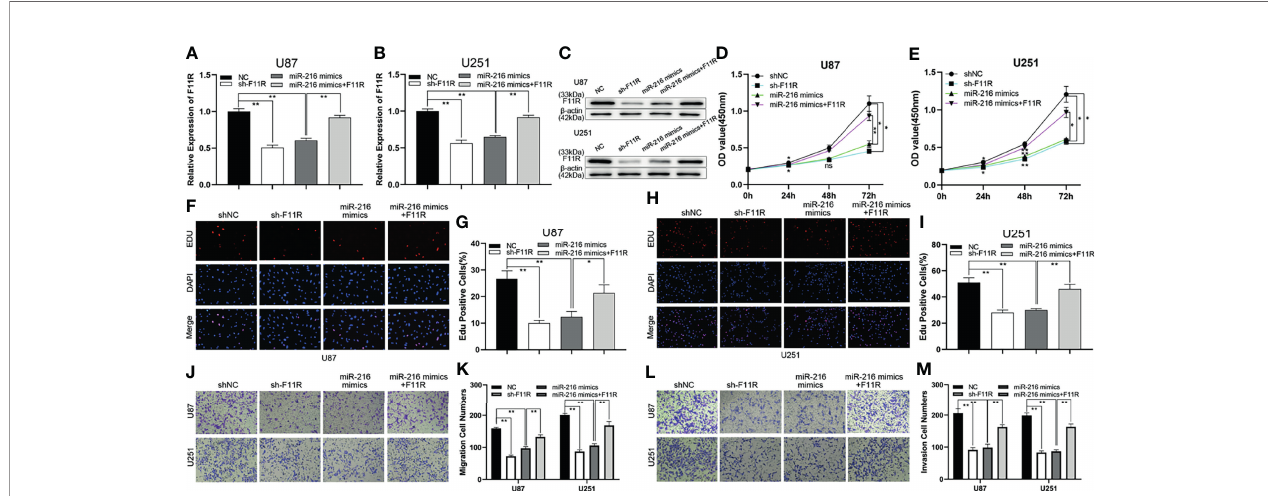
FIGURE 4 | MiR-216 could inhibit glioma proliferation, migration, and invasion by targeting F11R. (A – C) qRT-PCR and western blot were used to test the expression of F11R in U87 and U251 cells transfected with NC, sh-F11R, miR-216 mimics, or miR-216 mimics together with F11R plasmids. (D, E) CCK-8 assay was used to test the proliferation of U87 and U251 cells transfected with NC, sh-F11R, miR-216 mimics, or miR-216 mimics together with F11R plasmids. (F – I) EdU assay was used to test the proliferation of U87 and U251 cells transfected with NC, sh-F11R, miR-216 mimics, or miR-216 mimics together with F11R plasmids. (J, K) Transwell assay was used to test the migration of U87 and U251 cells transfected with NC, sh-F11R, miR-216 mimics, or miR-216 mimics together with F11R plasmids. (L, M) Transwell assay was used to test the invasion of U87 and U251 cells transfected with NC, sh-F11R, miR-216 mimics, or miR-216 mimics together with F11R plasmids.One-way ANOVA and post hoc test for (A, B, G, I, K, M) . Two-way ANOVA and post hoc test for (D, E) . *P < 0.05, **P <